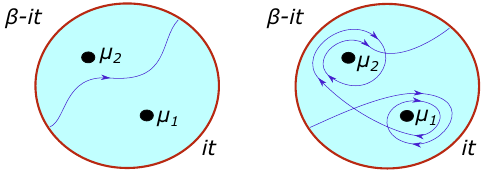
Figure 18 . Wilson line con(cid:12)guration of the non-self-crossing class (left) and of the self-crossing class